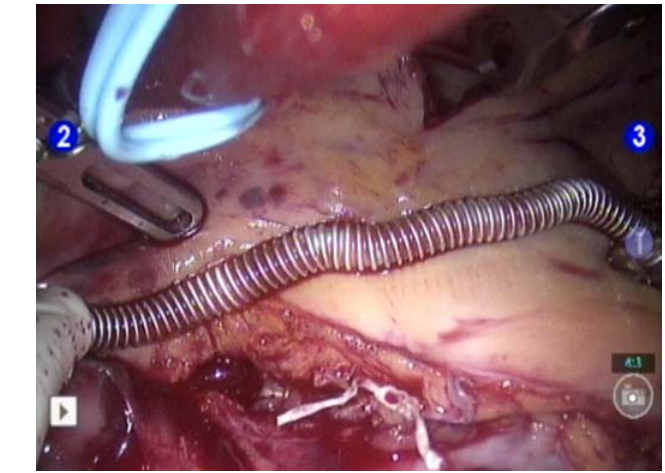
Figure 8. Intercaval lesion from lateral aspect of SVC to IVC.